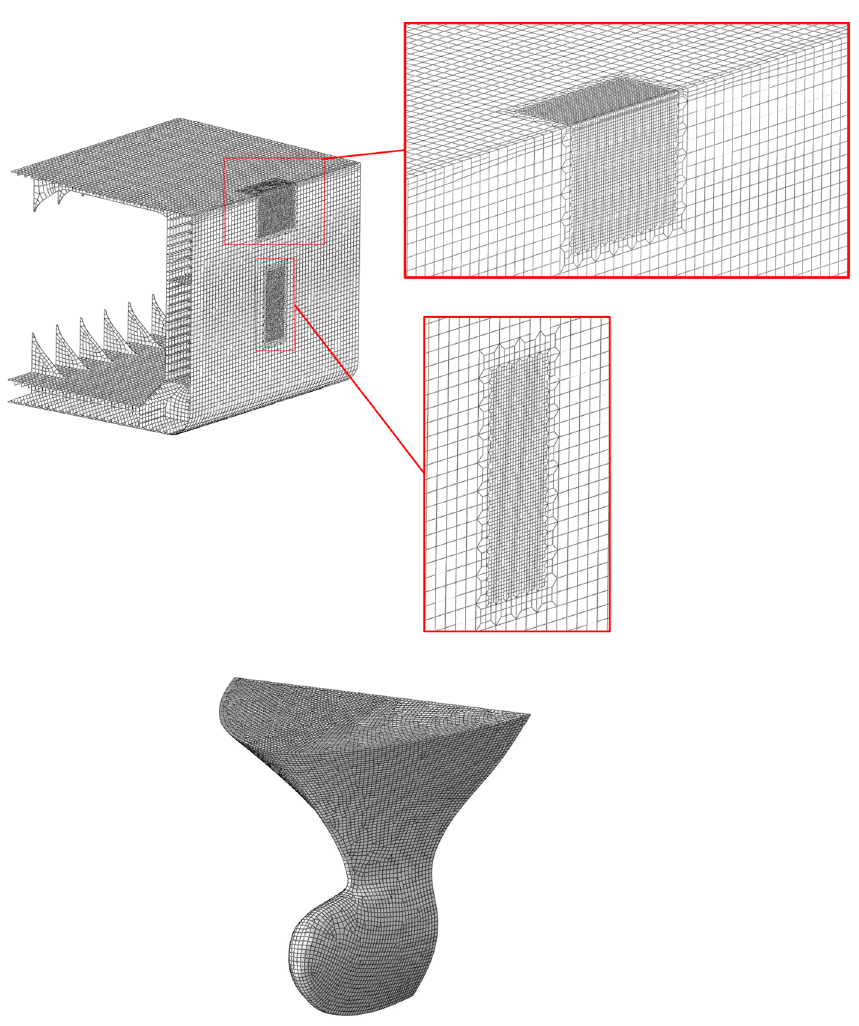
Figure 6. Finite element models and mesh of the struck FPSO and striking supply vessel bow.